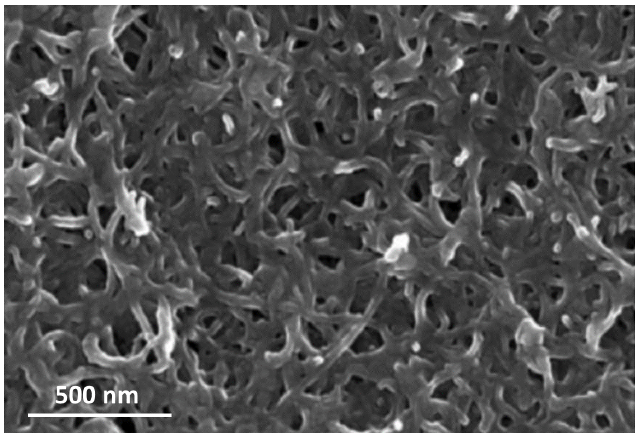
Figure 8. High resolution scanning electron microscopy (HRSEM) image of MWCNT/PANI nanocomposites prepared by ultrasonically induced inverse emulsion polymerization (adapted from [28])